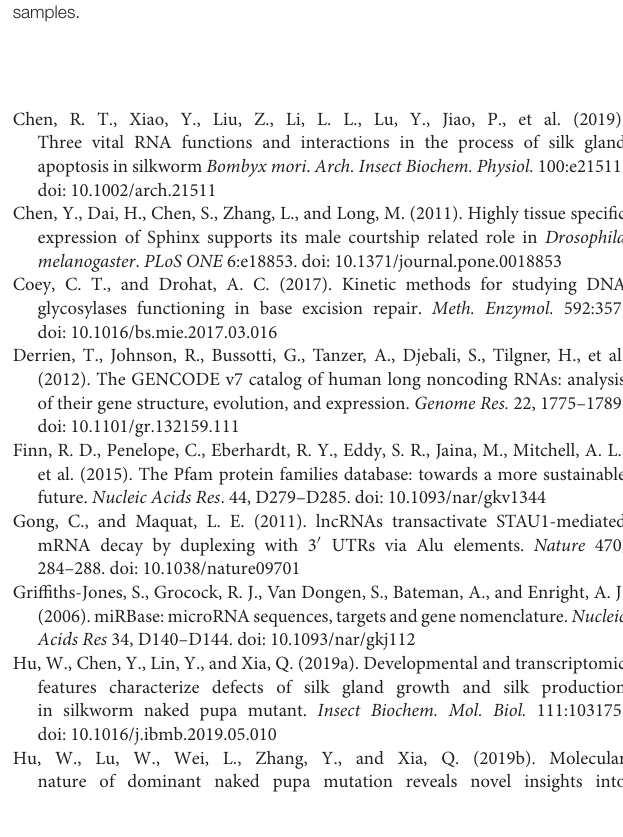
Supplementary Table 15 | The concentration and quality information of RNA